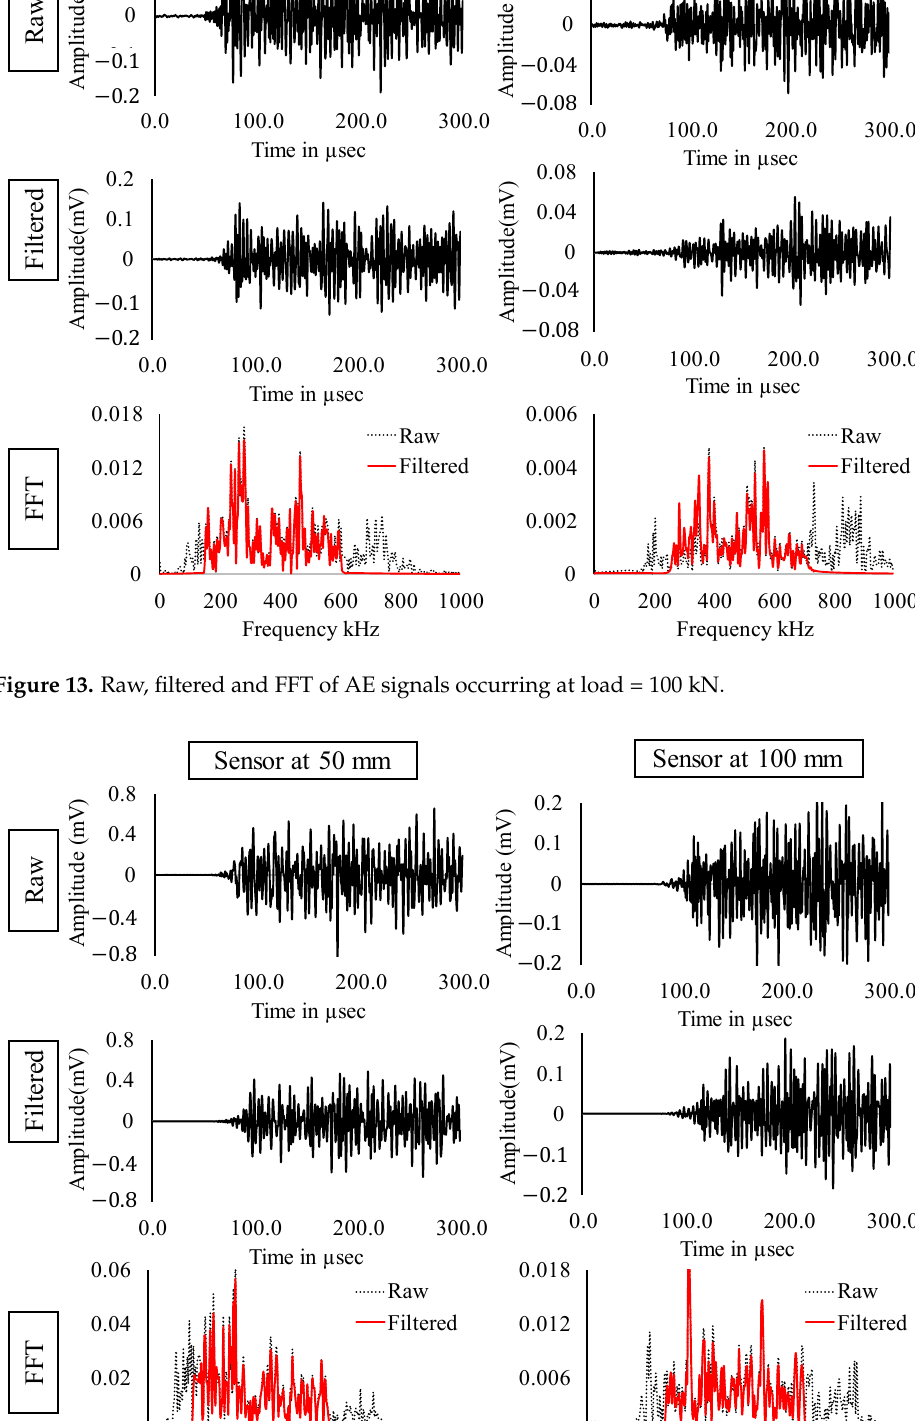
Figure 15. Raw, filtered and FFT of AE signals occurring at load = 200 kN.